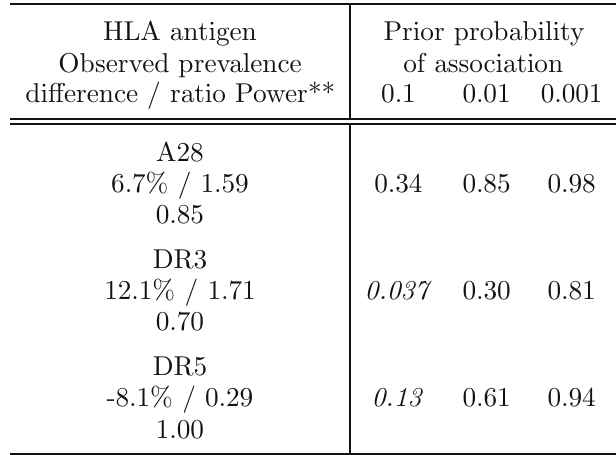
Table 2B False positive report probability (F) values to test the observed statistically significant differences/ratios in the phenotype prevalences of HLA antigens between PBC patients and healthy donors (reported in Table